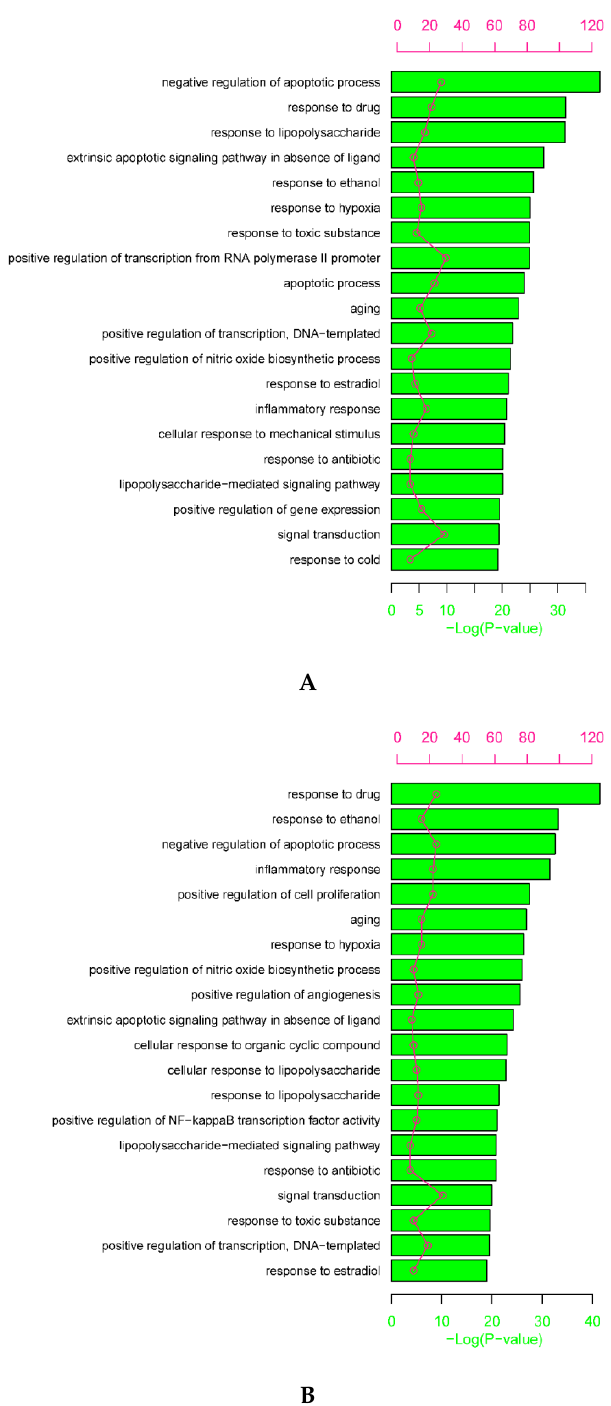
Figure 4. The top 20 significant gene ontology enrichment analysis for intersection targets between ( A ) compound (OB ≥ 30% and DL ≥ 0.18) and AD-related targets, and ( B ) compound (OB < 30% and DL ≥ 0.18) and AD-related targets. The circles represent the gene count of each biological process. AD: atopic dermatitis. OB: oral bioavailability; DL: drug-likeness.